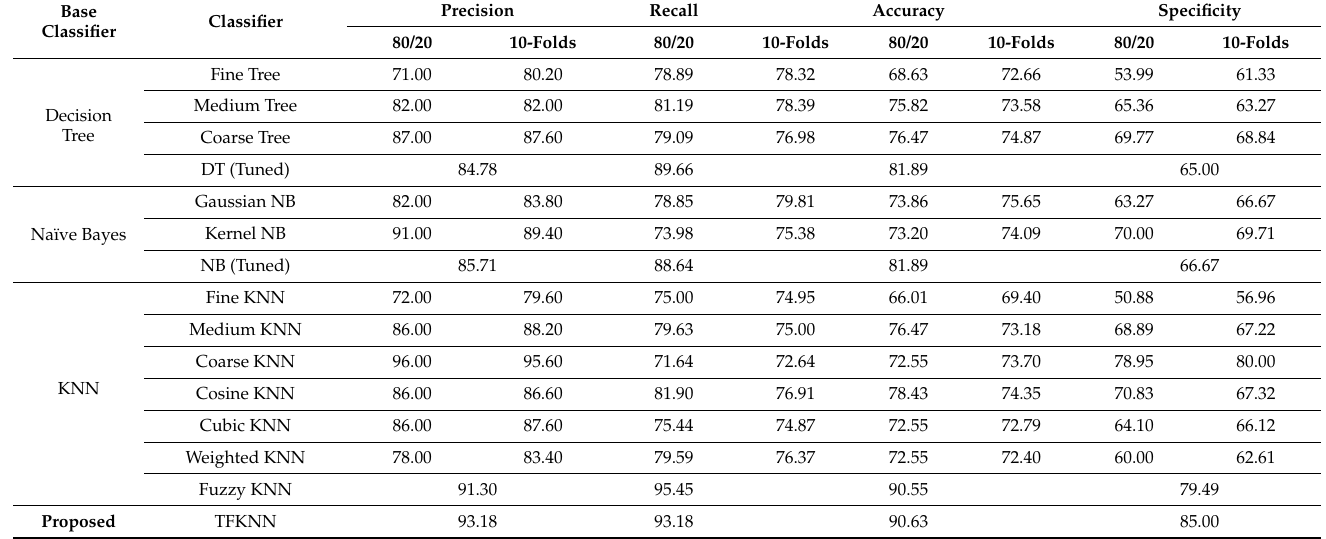
Table 11. Comparative empirical results analysis of the proposed uncertainty fuzzy KNN versus others.